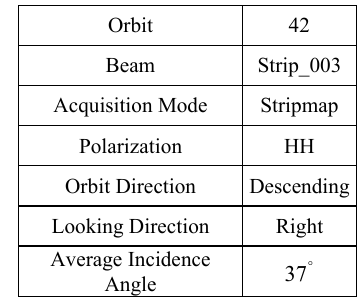
Table 1. System parameters for the pre- and post-event TSX images The pre- and post-event TSX images (Figure 2) used in this study have been acquired on October 20, 2010 and March 12, 2011, respectively. The corresponding system parameters are listed in Table 1. The time interval of both TSX images is 143 days, which is not optimal with respect to temporal de- correlation. Nevertheless, this pair is still useful because the post-event TSX image was taken just one day after the Tohoku event. Therefore, the destruction caused by the earthquake and tsunami is assumed to be captured completely.